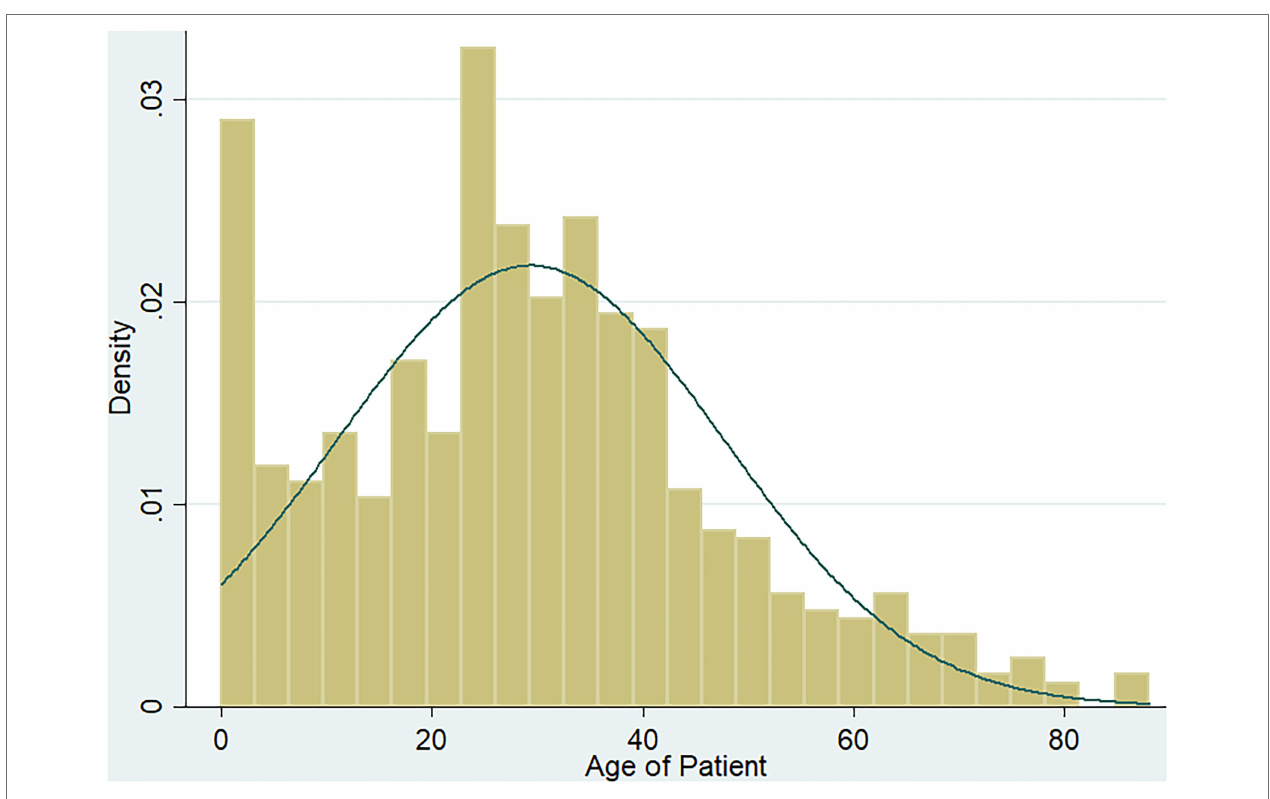
FIGURE 2 | Age distribution of participants.